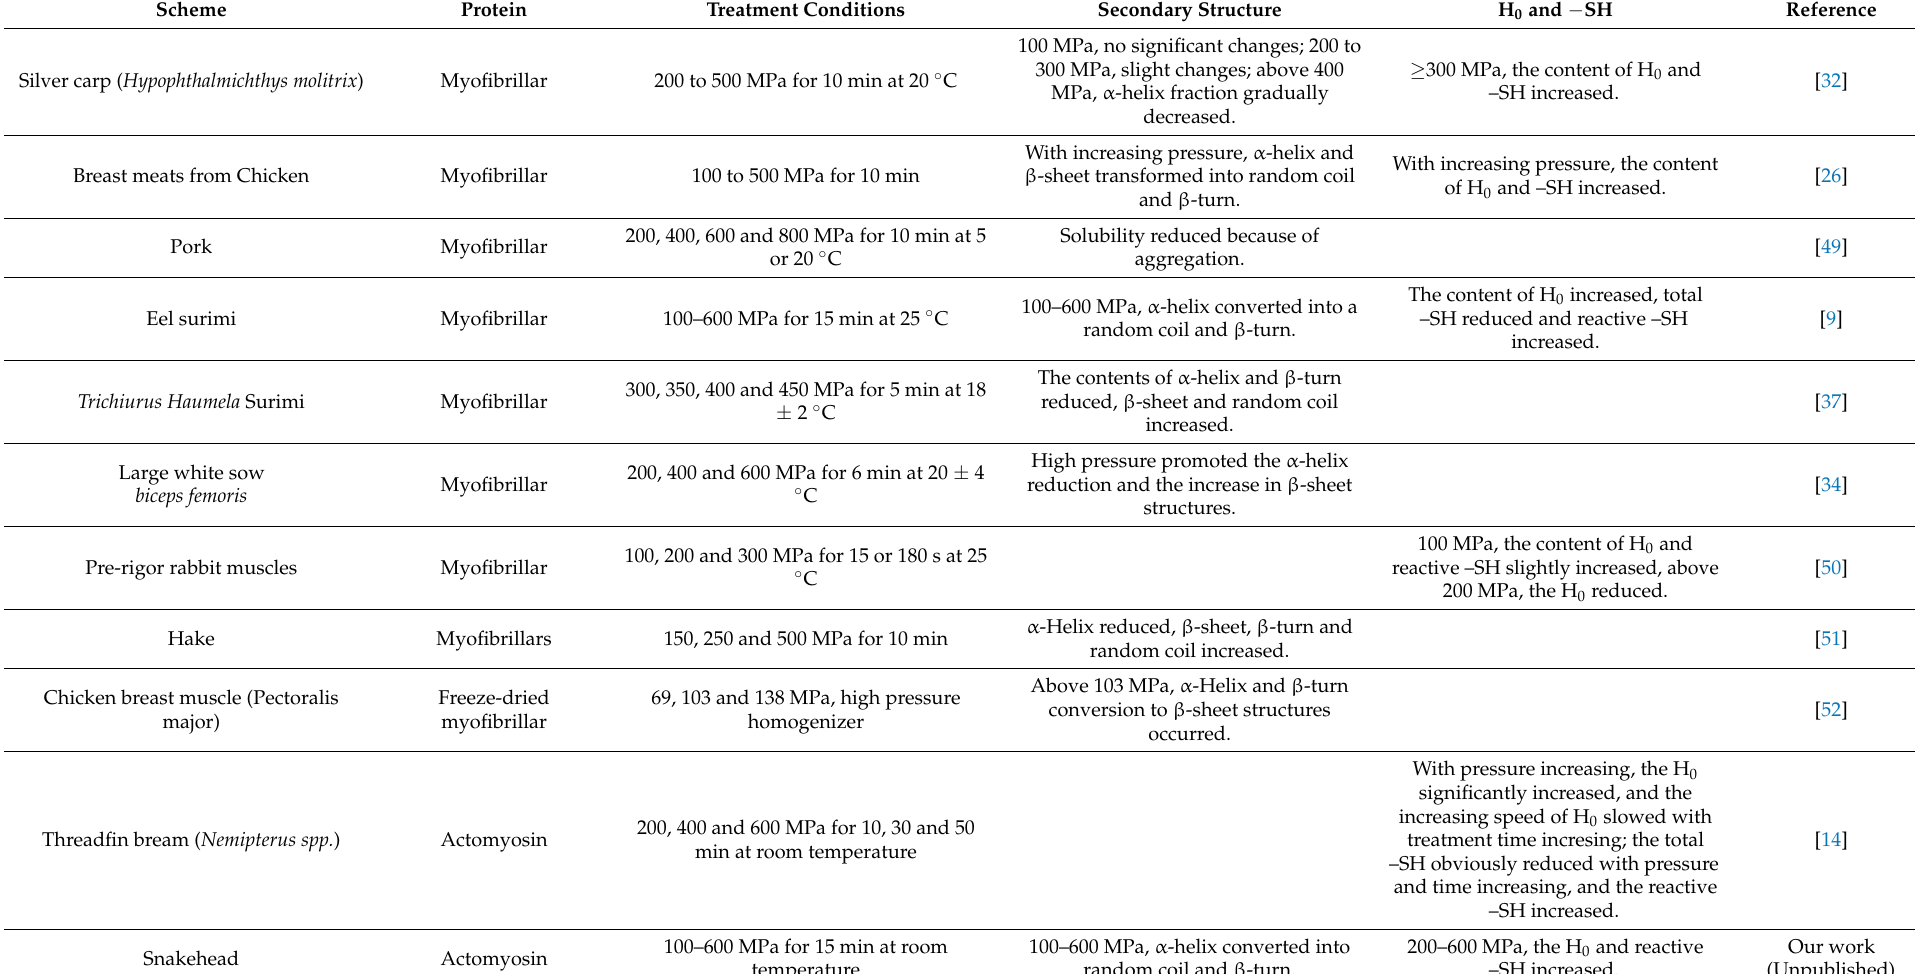
Table 1. Changes in myofibrillar protein structure under HHP, including source, reaction conditions and relevant